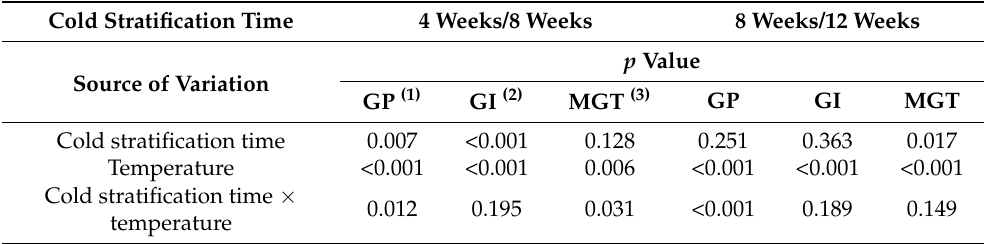
Table 2. Variance analysis of the effects of cold stratification and temperature on germination of F. rhynchophylla